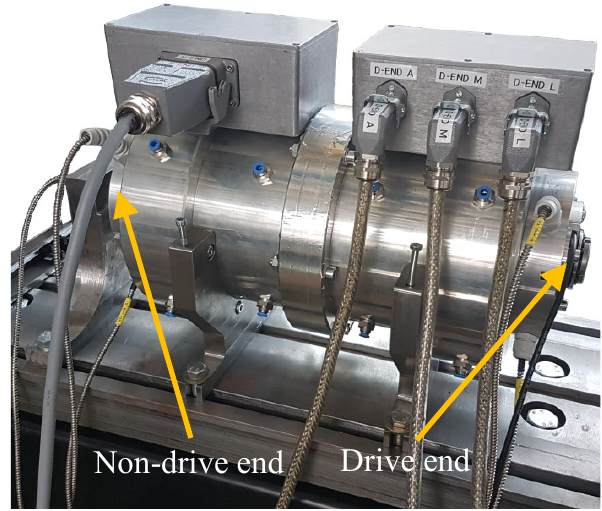
Figure 1: Photograph of the 10kW dual motor bear- ingless machine. The axial AMB is in the middle of the machine and bearingless mo- tors are located on both ends.